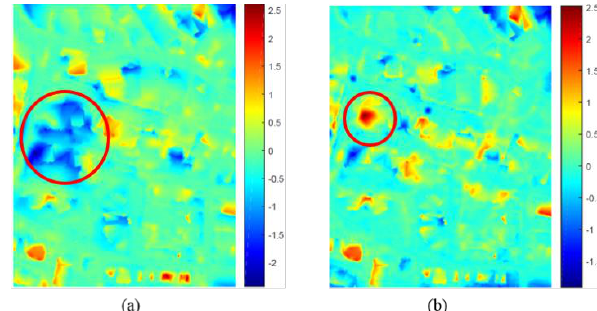
Figure 9. Area (2) height differences maps of the created DTMs with LiDAR DTM. MSD (a) and NGPs (b). Table 4 shows the calculated Mean-squared errors (MSEs) and standard division (SD) of the height differences. The MSE and